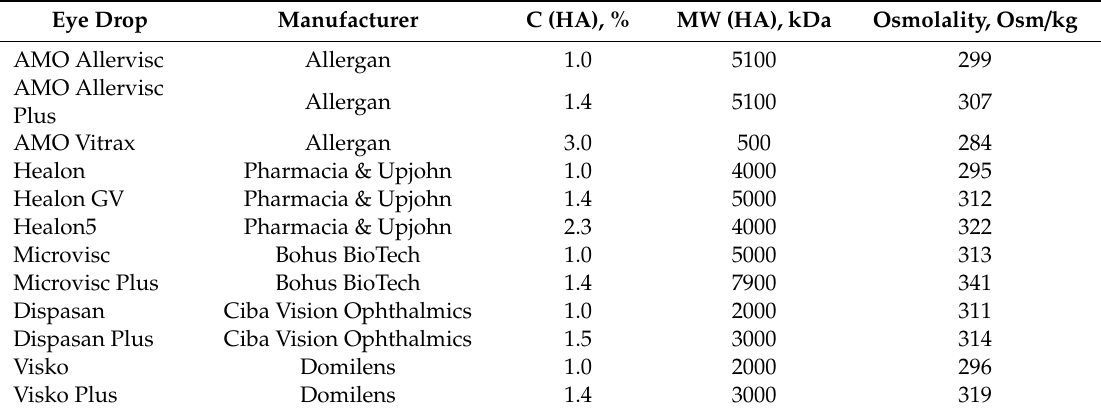
Table 4. Examples of lubricant eye drops and their